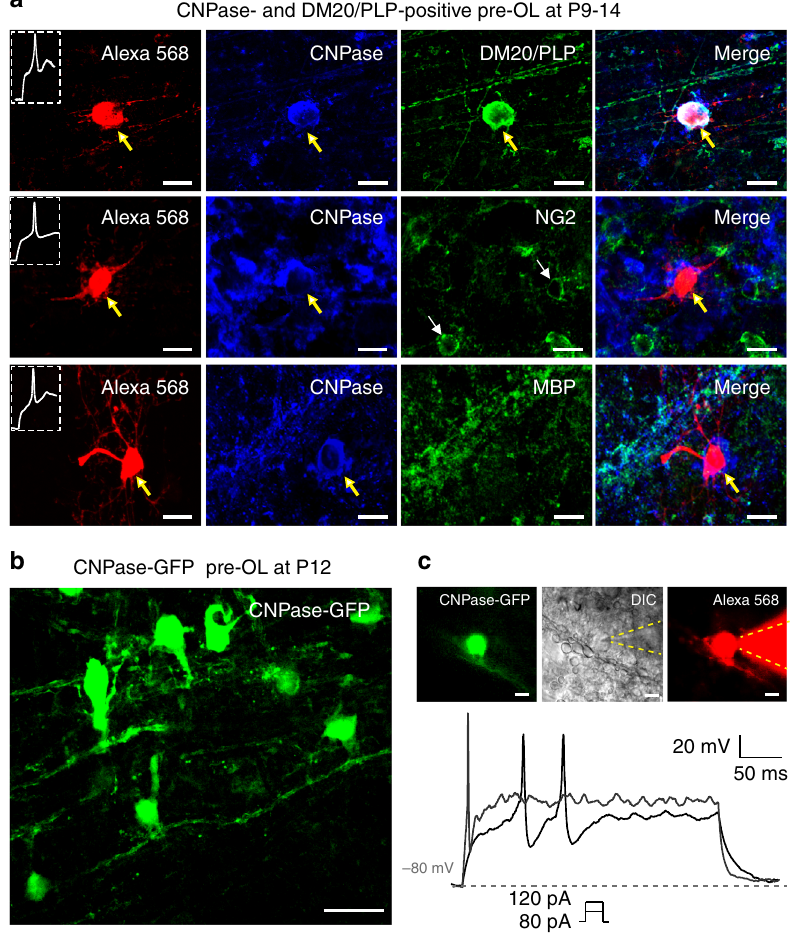
Fig. 2 Excitable OLs belong to the pre-myelinating OL stage. a Post-recording immunostaining of Alexa 568- fi lled excitable OLs ( red ) for CNPase ( blue ) and DM20-PLP ( green , upper ), NG2 ( green , middle ), or MBP ( green , lower ) in the MNTB (P9 − P14). b Confocal image of CNPase-GFP+ cells in the MNTB that were infected by adenovirus encoding pAV.ExSi-CNPase promoter-eGFP. c CNPase-GFP+ pre-OLs in the MNTB. A CNPase-GFP+ pre-OL was fi lled with Alexa 568 during whole-cell recording, as demonstrated in differential interference contrast (DIC) and fl uorescence images. Dashed lines indicate the patch pipette. The CNPase-GFP+ pre-OL fi red APs in response to step-current injections of 80 and 120 pA (300 ms). Scale bar , 10 μ